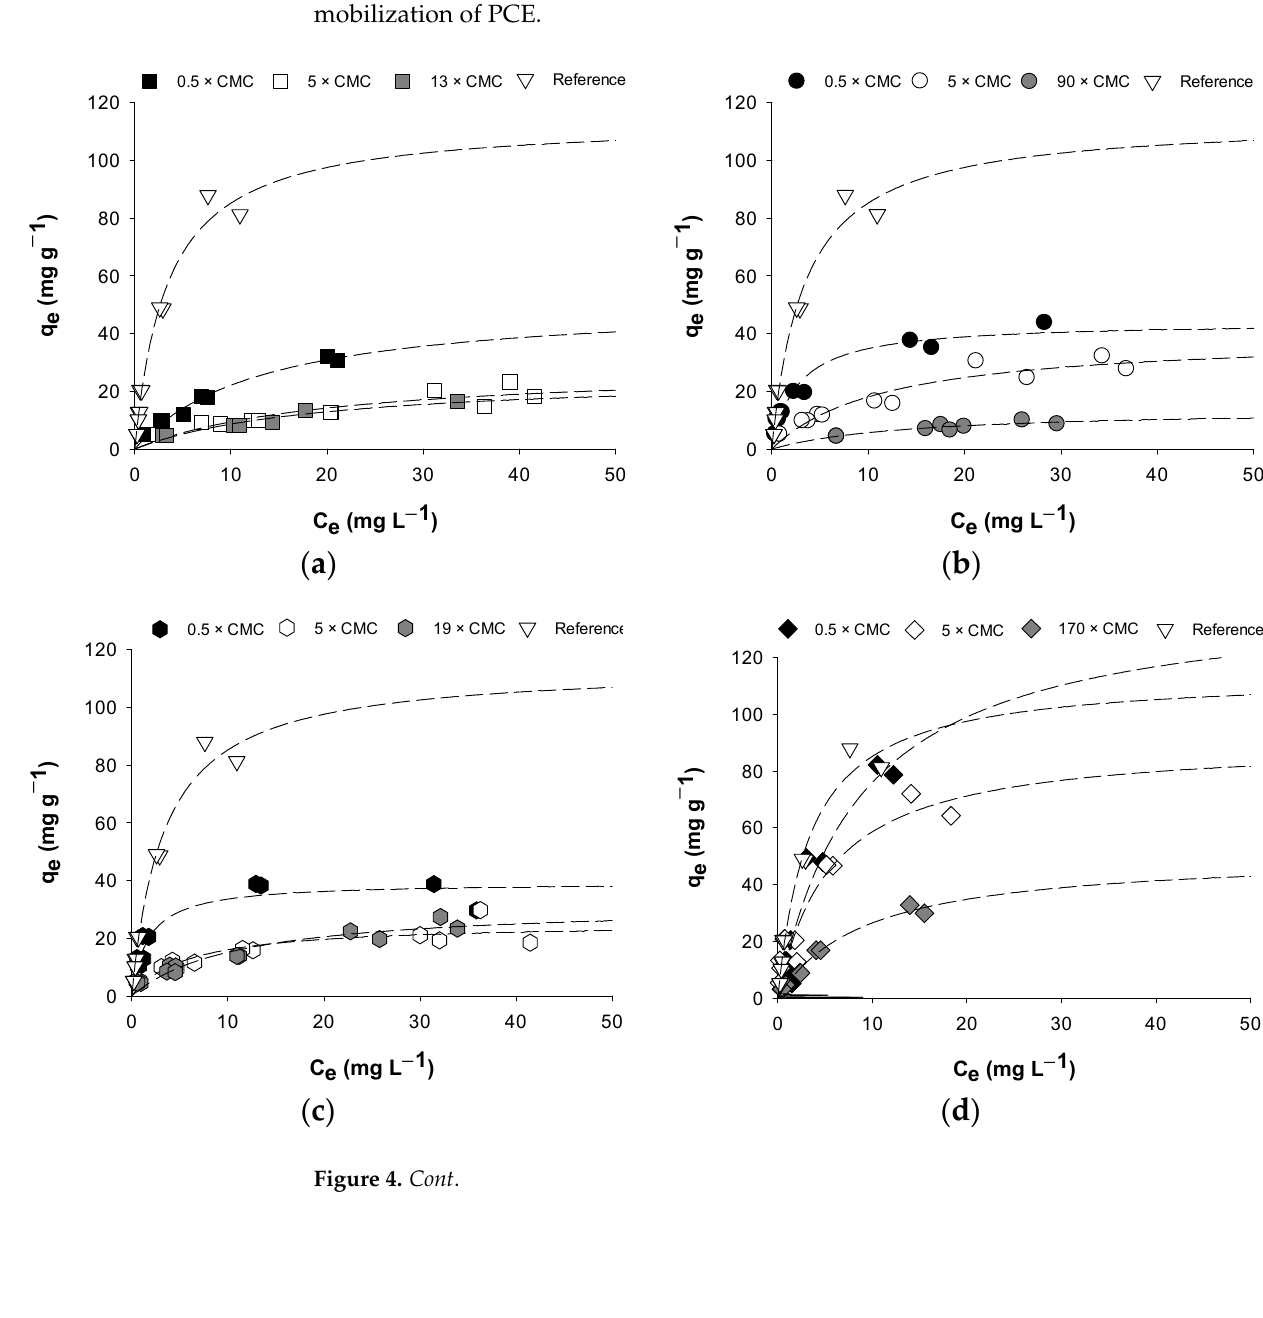
( e ) Figure 4. Isotherm curve of PCE on PWB, and surfactant solutions in different concentrations: ( a ) APG1, ( b ) APG2, ( c ) SL, ( d ) RL1, ( e ) RL2. Table 4. Optimized parameters of the Langmuir model of PCE on PWB in the presence and in the absence of surfactants.